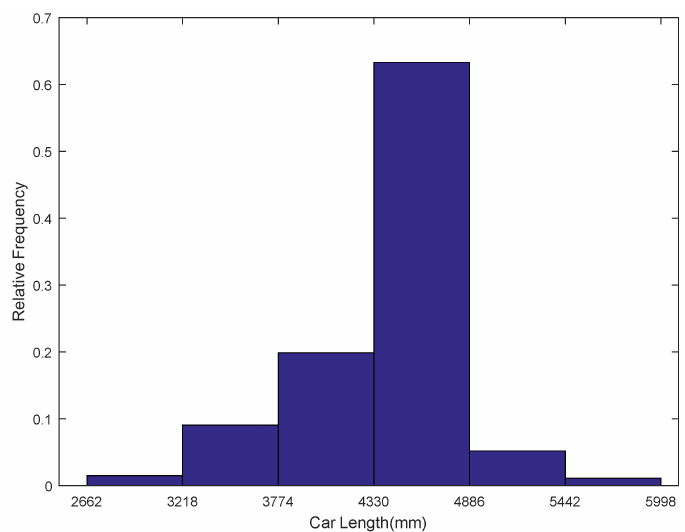
Figure 4. Histogram for the length distribution of passenger cars.